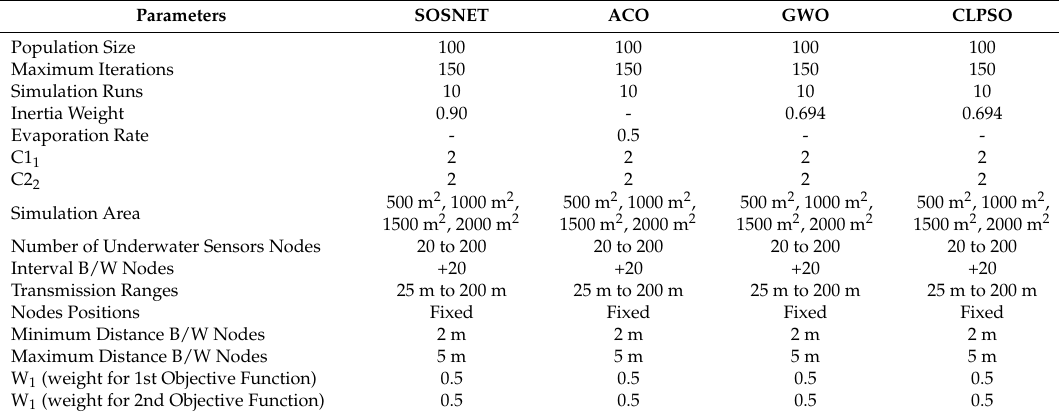
Table 1. Simulation